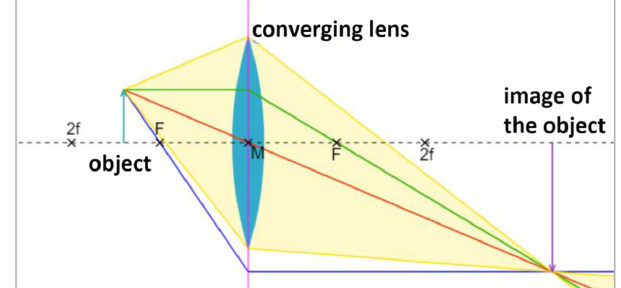
FIG. 2. Conceptual idea of the refraction and imaging process drawn in a ray diagram according to the three rules of refraction. The three construction rays predict where a point of the object is projected (parallel ray in green, central ray in red, and focal-point ray in blue). The yellow shaded area represents the bundle of light rays originating from the top point of the object that is refracted by the